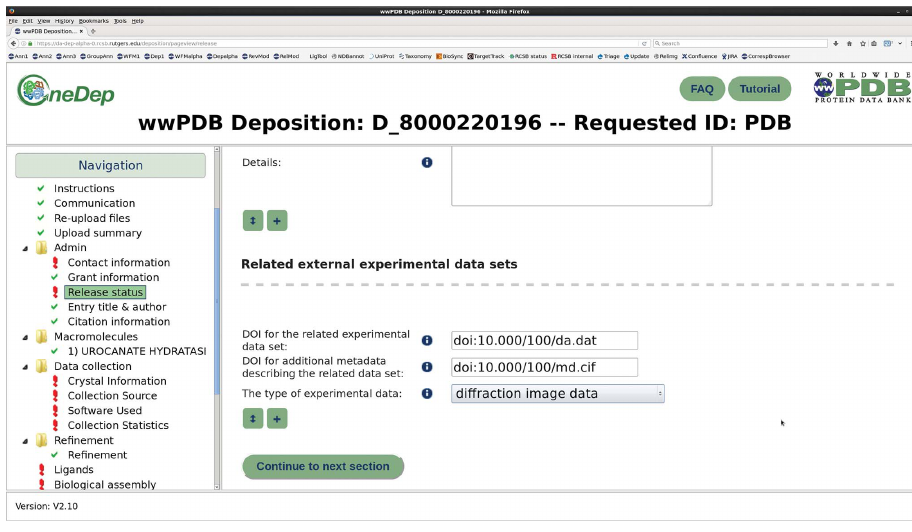
Figure 1 The wwPDB Deposition and Annotation System (Young et al ., 2017) now allows depositors to identify the location (doi) of their related experimental data set and its supporting metadata. Figure kindly provided by the RCSB Protein Data Bank and reproduced here with